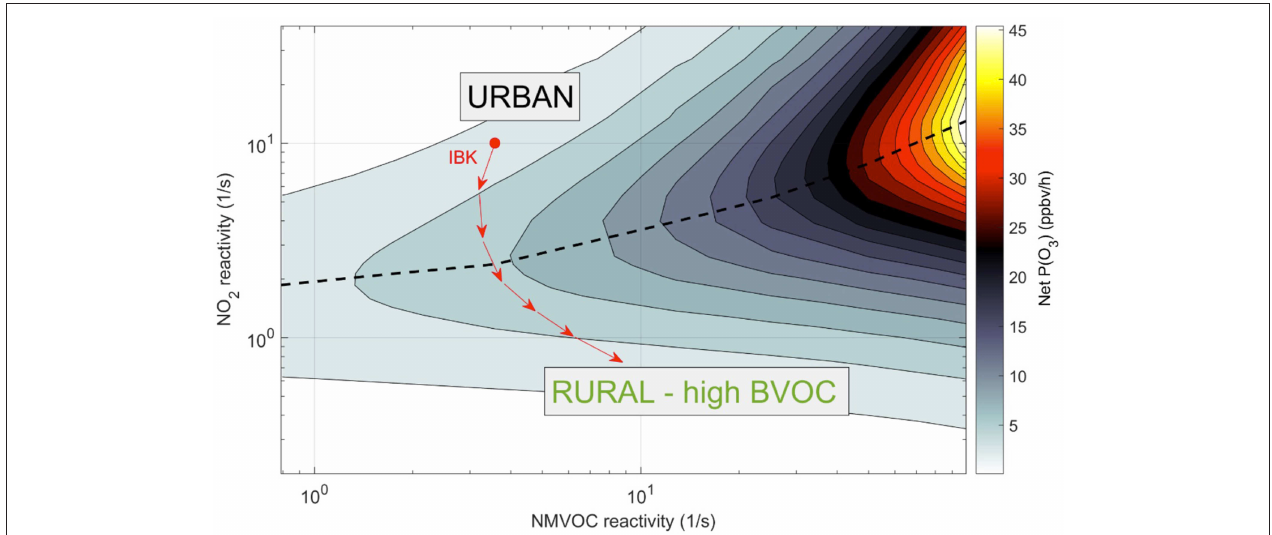
FIGURE 3 | Ozone isopleth showing urban (black) and rural (green) conditions of the relationship of NMVOC, NO x , and O 3 . Calculations are based on a model-measurement analysis for Innsbruck (Karl et al., 2017) based on the full chemistry MCM from Leeds (http://mcm.leeds.ac.uk/MCM/). Rural area conditions characterized by high BVOC emissions represent a typical range observed in the Southeast USA (Kaser et al., 2015). The trajectory to the rural end point was estimated based on a typical scenario (Ehlers et al., 2016). The MCM was implemented in Matlab (C) based on Wolfe and Thornton (2011). The red inset denotes a hypothetical trajectory from NO x -rich urban conditions to BVOC-rich rural conditions in Innsbruck, Austria.